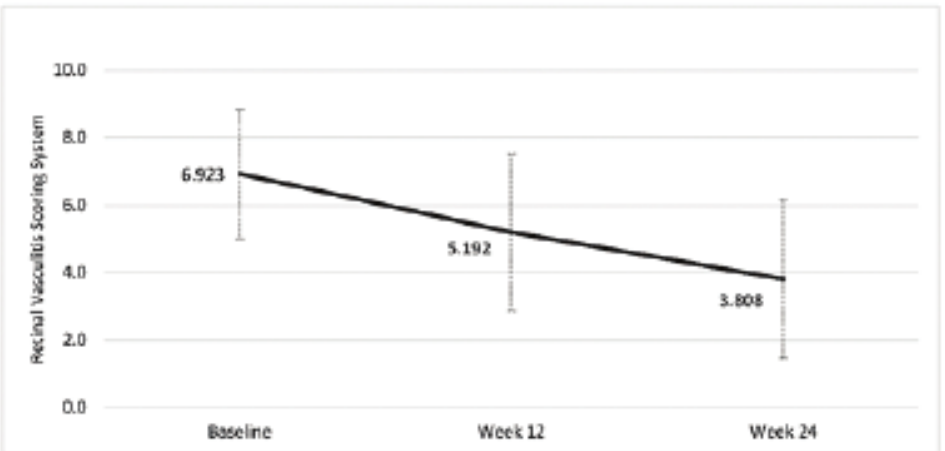
Figure 3. Mean RL for PPP eyes at each study visit after